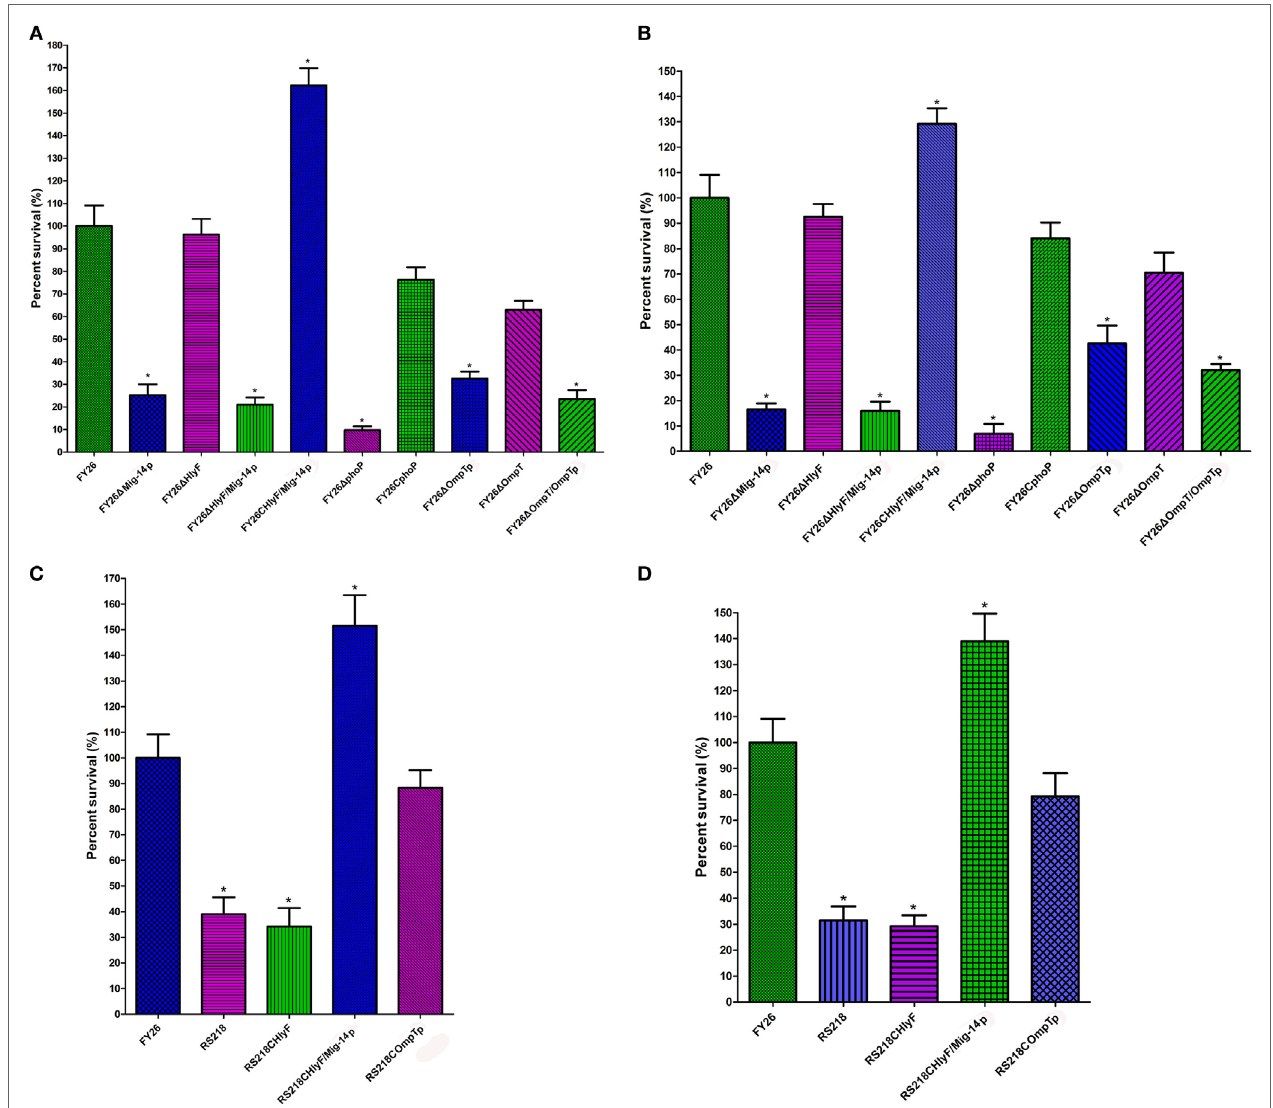
FigUre 3 | The Mig-14p and OmpTp conferring extraintestinal pathogenic Escherichia coli (ExPEC) resistance to CAMPs. CAMPs killing assays were conducted to determine the roles of Mig-14p and OmpTp in ExPEC resistance to CAMPs. (a) The sensitivity of wild-type FY26, the Mig-14p mutant, the OmpTp mutant, and complemented strains to LL-37. (B) The sensitivity of wild-type FY26, the Mig-14p mutant, the OmpTp mutant, and complemented strains to HBD2. (c) CAMPs killing assays were conducted to determine that overexpression of Mig-14p and OmpTp in RS218 increased its resistance to LL-37. (D) Overexpression of Mig-14p and OmpTp in RS218 increased its resistance to HBD2. Data are expressed as the percent difference in survival following a 2 h exposure to LL-37. Survival in each assay was normalized to the value of the wild-type FY26. Data acquired from at least four independent experiments, and the mean values ± SEs were shown. The statistically significant differences were determined using one-way ANOVA analysis (* P <